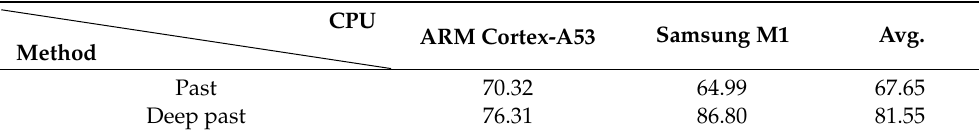
Table 8. Phase prediction rate for each method (unit: prediction rate (%)). Method